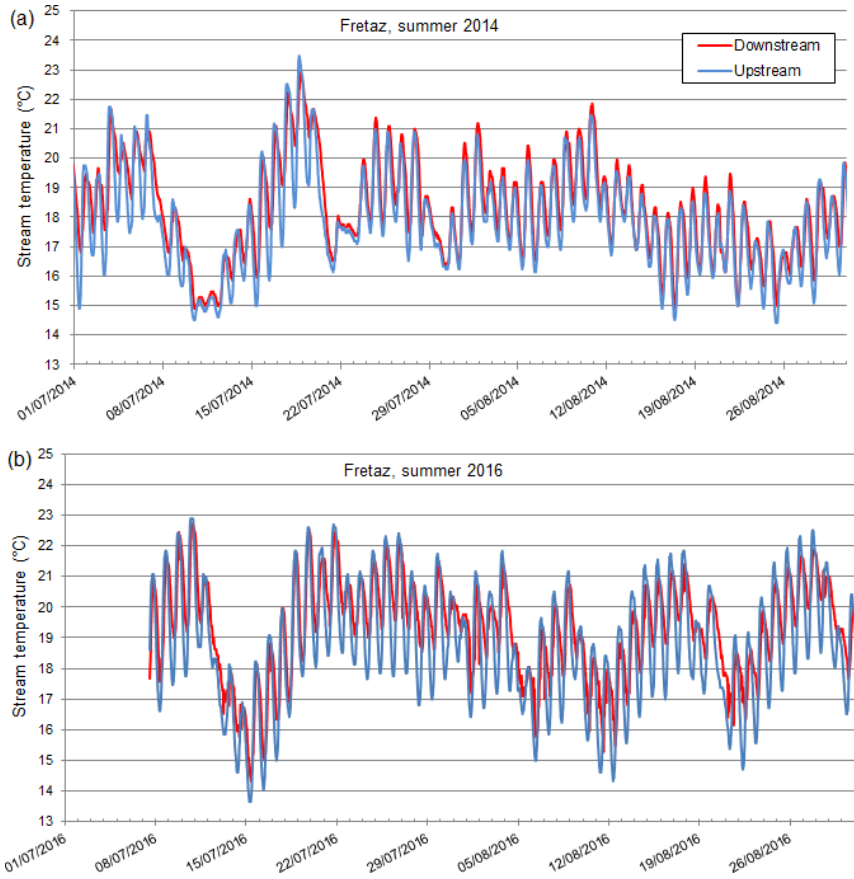
Figure 2. Time series of water temperature ( ◦ C) upstream (blue) and downstream (red) of the Fretaz dam in the Veyle stream, respectively, in the years 2014 (a) and 2016 (b) . These example sites are illustrative of the group A typology, where T min is increased downstream but T max is